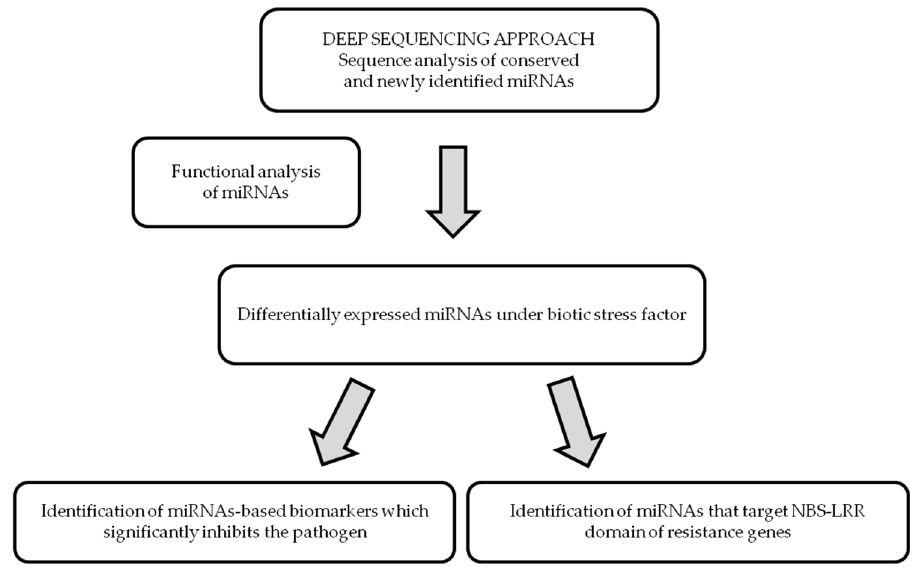
Figure 1. Methodological platform of miRNA-based strategies in crop improvement to biotic stress factors. Note: NBS-LRR - nucleotide-binding site (NBS)–leucine-rich repeat (LRR).